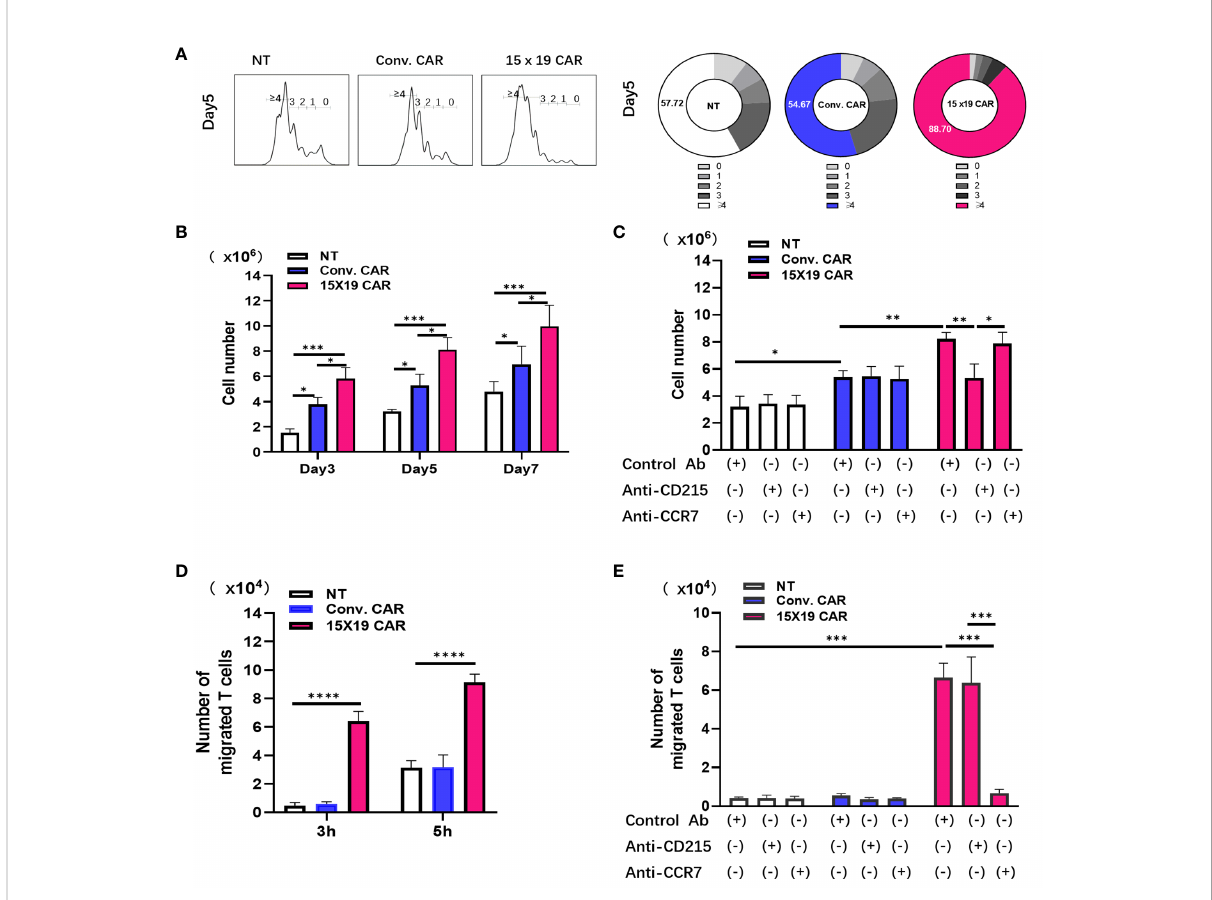
FIGURE 4 15 × 19 CAR T cells promote T cell proliferation and migration. (A) Cells in the NT, conventional CAR and 15 × 19 CAR groups are stained with Cell Proliferation Dye eFluor ™ 670, co-cultured with mitomycin C-treated HCG-27 cells, and incubated for 3 days. Number of differentiated cells is shown in the histogram. Numbers in the donut charts represent the percentage of each gated fraction in the cell culture; (B) , The absolute numbers of survival cells in the NT, conventional CAR and 15 × 19 CAR groups at different time points; (C) ,Antibody-blocking assay detects the effects of CD215 or CCR on cell proliferation. The absolute numbers of living cells are estimated after CD215 or CCR7 antibody blockade. * P = 0.0491 (NT with Control antibody vs. Conv. with Control antibody);** P = 0.0051 (Conv. with Control antibody vs. 15×19 with Control antibody); ** P = 0.0046 (15×19 with Control antibody vs. 15×19 with CD215);* P = 0.0148 (15×19 with CD215 vs. 15×19 with CCR7); (D) , Chemotaxis of T cells by cells in the NT, conventional CAR and 15 × 19 CAR groups. ***P < 0.0001(3 h); *** P < 0.0001 (5 h); (E) , Antibody- blocking assay detects the effects of CD215 or CCR on T cellchemotaxis. The migrating cells are estimated after CD215 or CCR7 antibody blockade. ***P < 0.0001(NT and Conv. with Control antibody vs. 15×19 with Control antibody). *** P < 0.0001 (15×19 with Control antibody vs. 15×19 with anti-CCR7), *** P < 0.0001 (15×19 with anti-CD215 vs. 15×19 with anti-CCR7).All data are described as mean ± SD from three independent experiments. Analyzed for statistical signi fi cance by one-way ANOVA with multiple comparisons